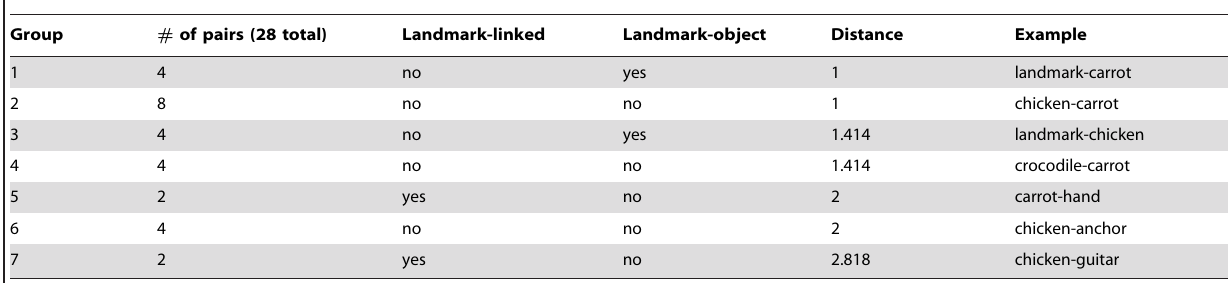
Table 1. The classification of object pairs in Experiment 1.